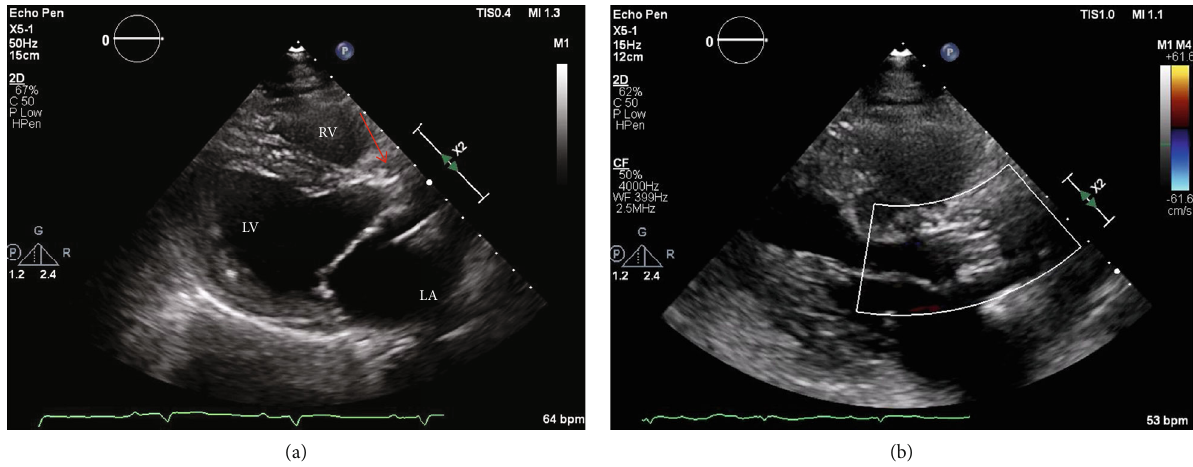
Figure 4: Transthoracic echocardiogram parasternal long-axis view. (a) Valve-in-valve TAVR (red arrow) with some artifacts causing suboptimal resolution and visualization of the bioprosthesis, yet no overt large vegetations were detected. No pericardial e ff usion present and systolic function was preserved (55%). (b) Diastolic frame showing no evidence of signi fi cant regurgitation by color Doppler. RV: right ventricle; LV: left ventricle; LA: left atrium.